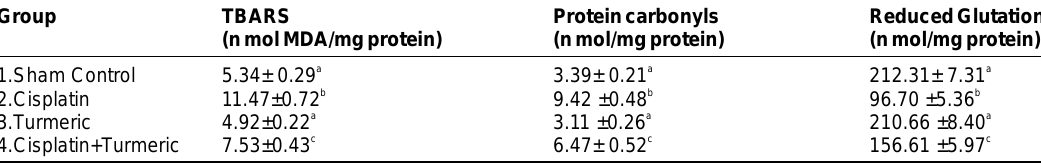
Fig. 14 TEM of kidney showing Fig. 16 TEM of kidney showing Fig. 15 TEM of kidney showing Fig. 13 TEM of kidney showing regenenerating mitochondria (M) proximal convoluting tubules with prominent inter tubular and inter nucleus (N) with uniform size, well and intact intertubular junction regenerating brush border (B), cellular junctions (J), prominent differrentiated nuclear membrane (itj) (Group 4, day 28). Uranyl swollen, elongated cilia (C) and nucleus (N), nucleolus (NL) and and nucleolus (NL), intact inner and outer nuclear membranes (NM) (Group 4, day 28). Uranyl Table-1. Kidney biomarkers of oxidative stress indifferent groups of rats